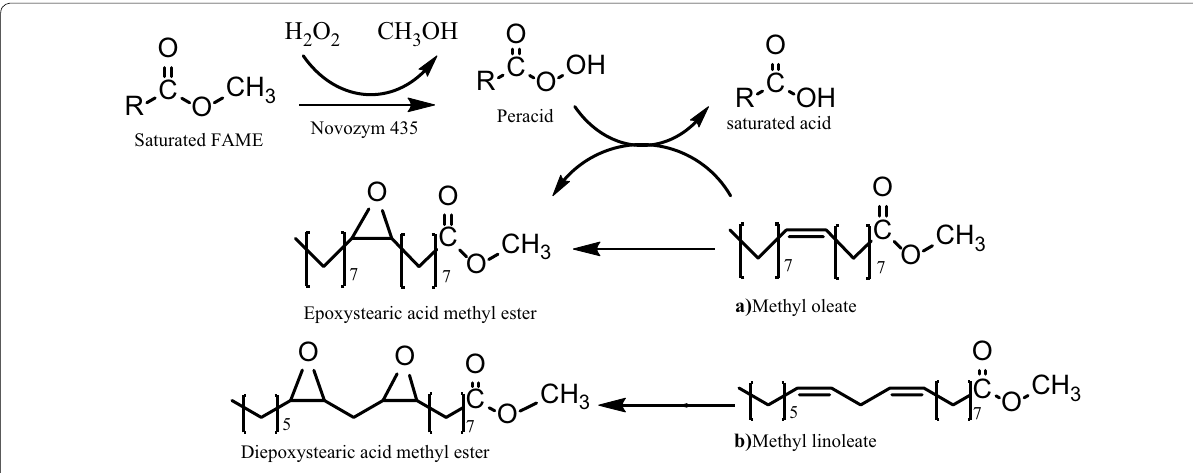
Fig. 4 Reaction mechanism of FAMEs epoxidation in absence of lauric